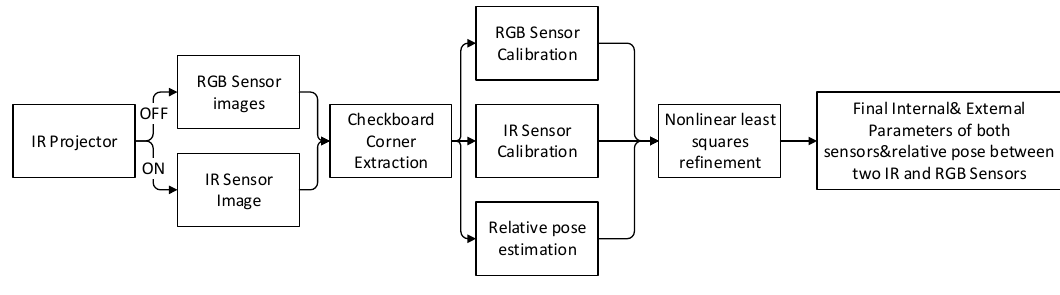
Figure 3. Methodology for RGB-D cameras Calibration.